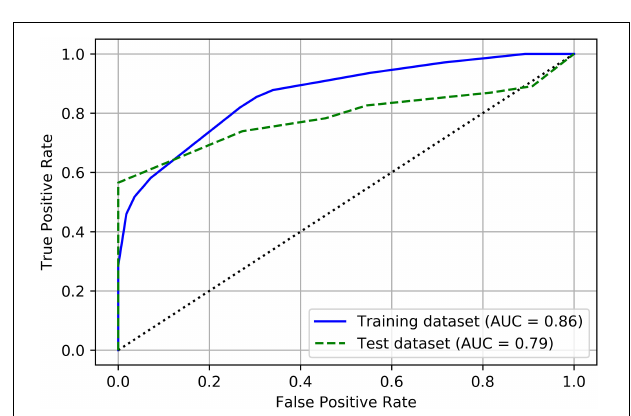
FIGURE 3 | Receiver operating characteristic (ROC) curves of the decision tree model for both training and test